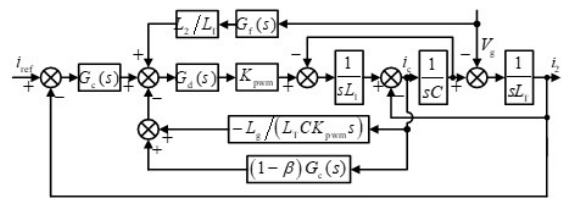
Fig. 4. CCFAD control system structure diagram of grid-connected